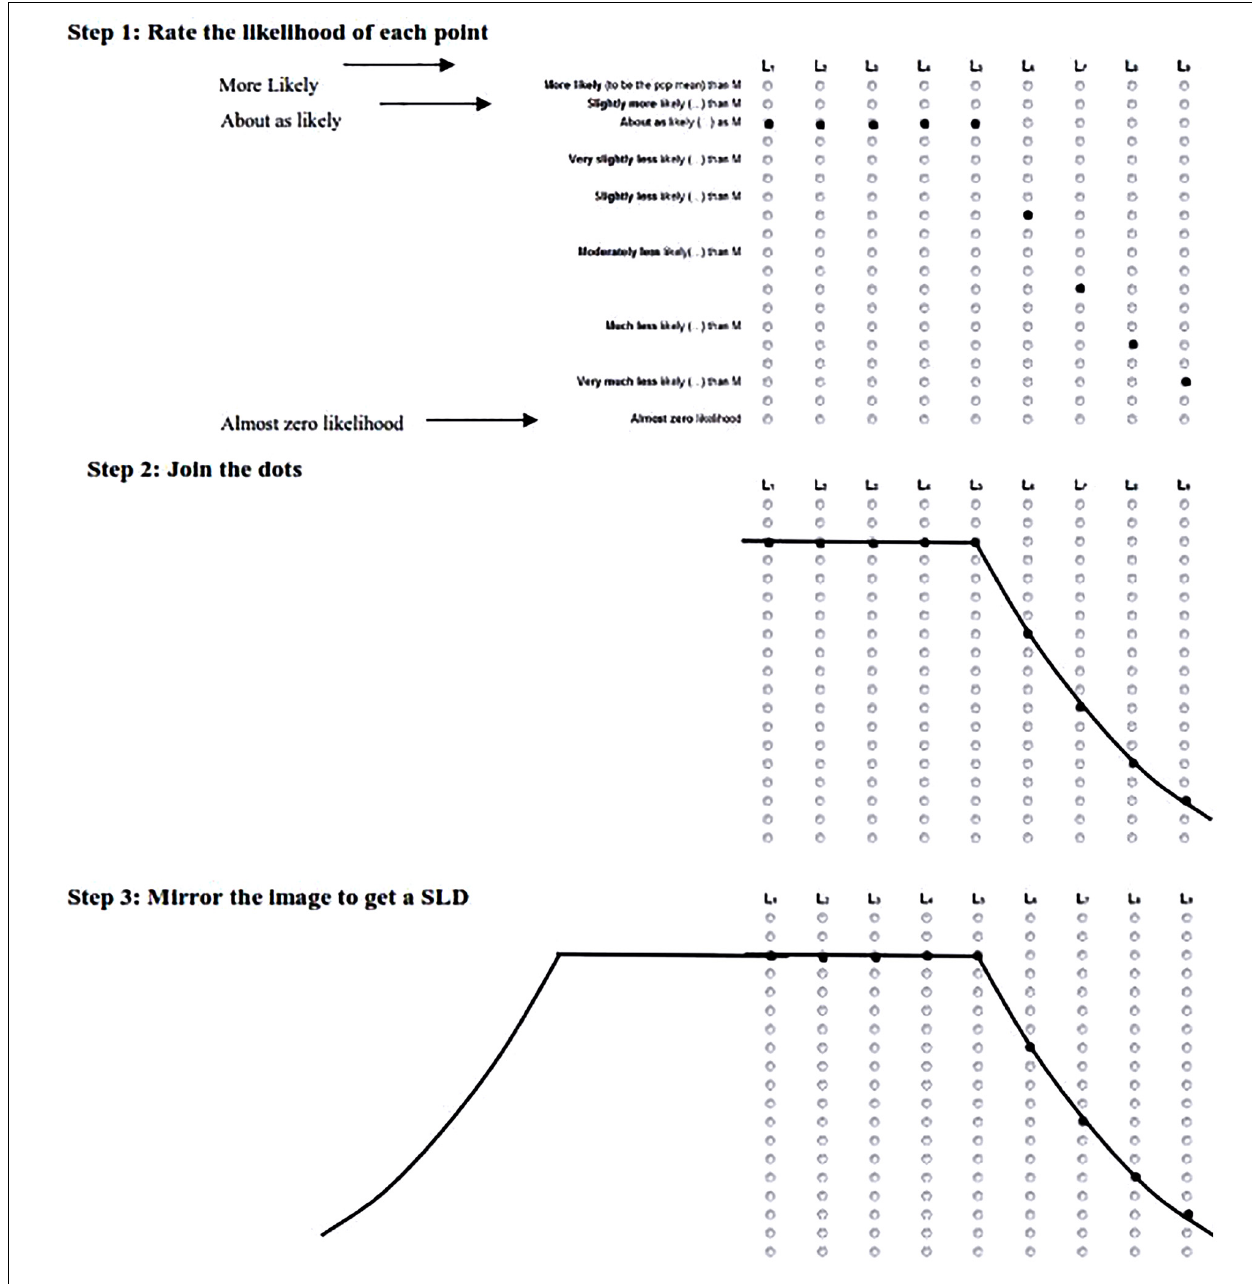
FIGURE 7 | Three steps used to elicit students’ CIs during Section “Introduction” of the interview. 5 1: dots marked by interviewer, to represent that student’s responses to Experiments 1, 2. Student joins the dots, 3. Interviewer extends the shape across the page to mirror the shape and draw the students SLD. L 1 to L 9 represent the corresponding points on Figure 2